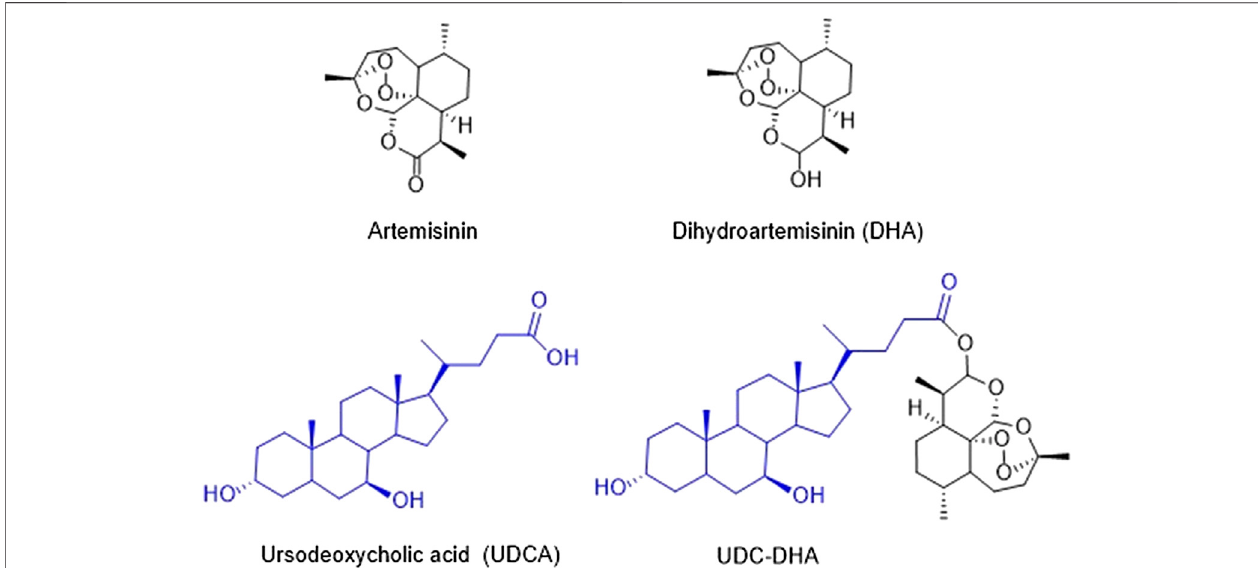
FIGURE 1 | Chemical structures of artemisinin, DHA, UDCA, and UDC-DHA.